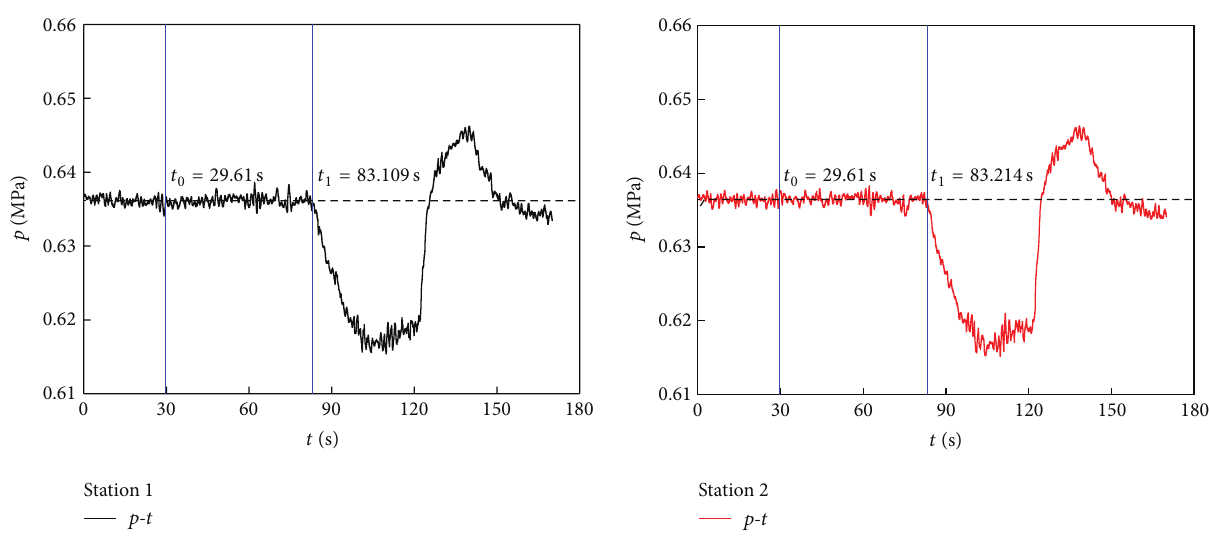
Figure 6: Pressure surge in the